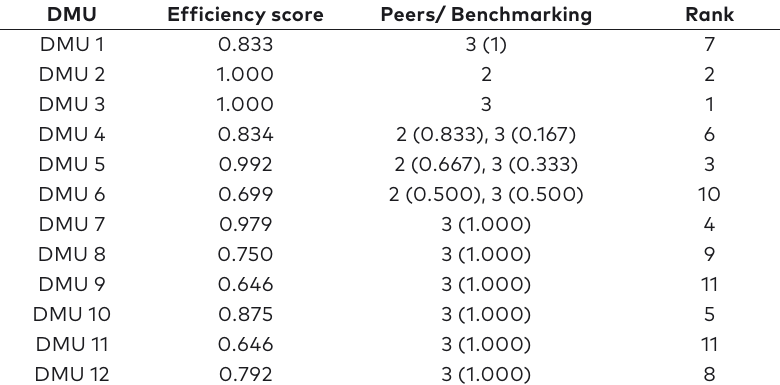
Table 4. Results of DEA for Framework 2